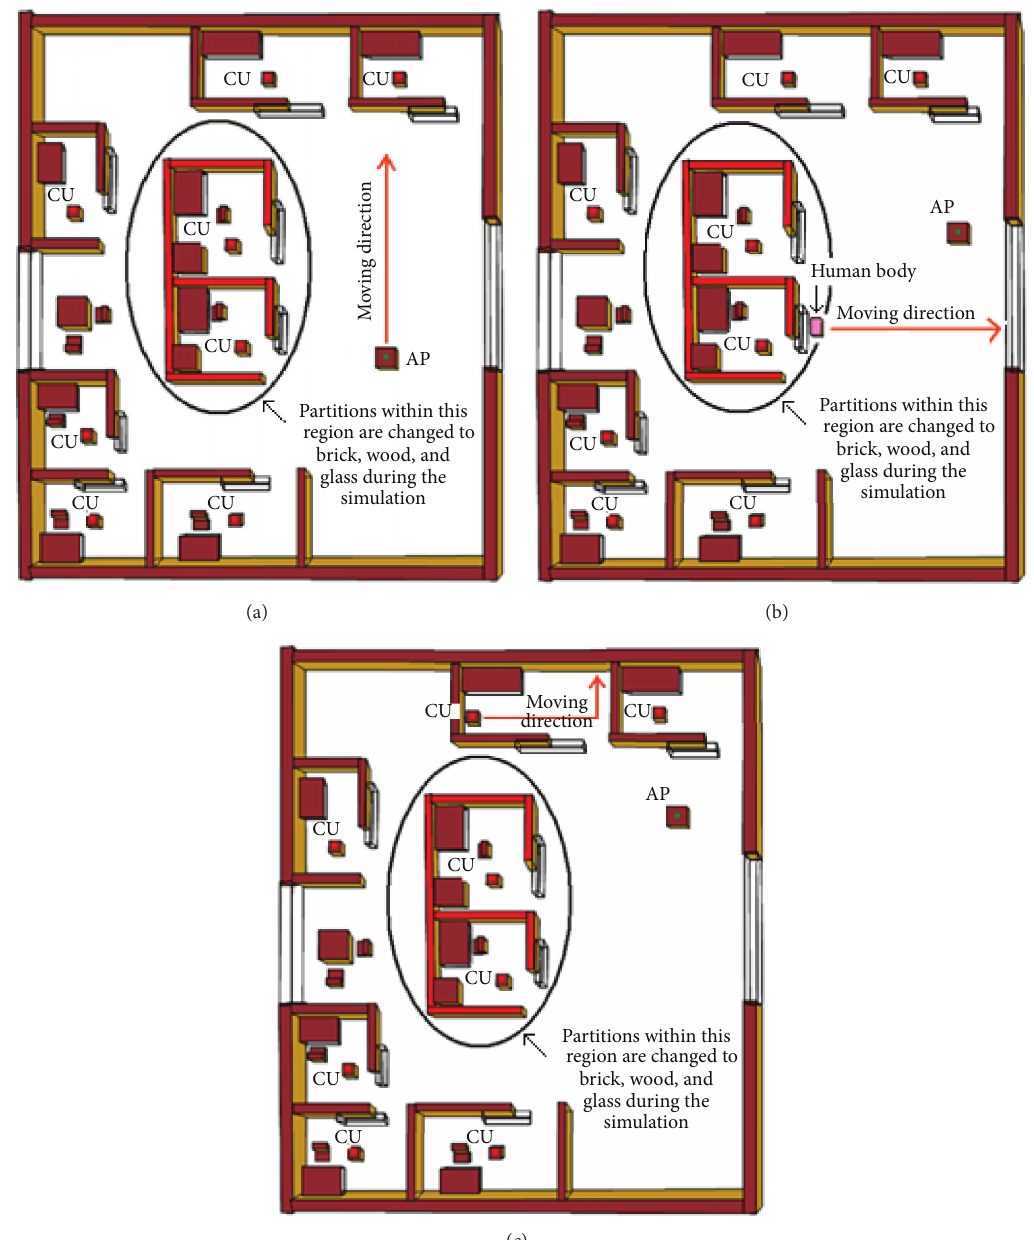
Figure 14: Illustration of (a) access point, (b) human, and (c) control unit movement in a sample hospital environment.